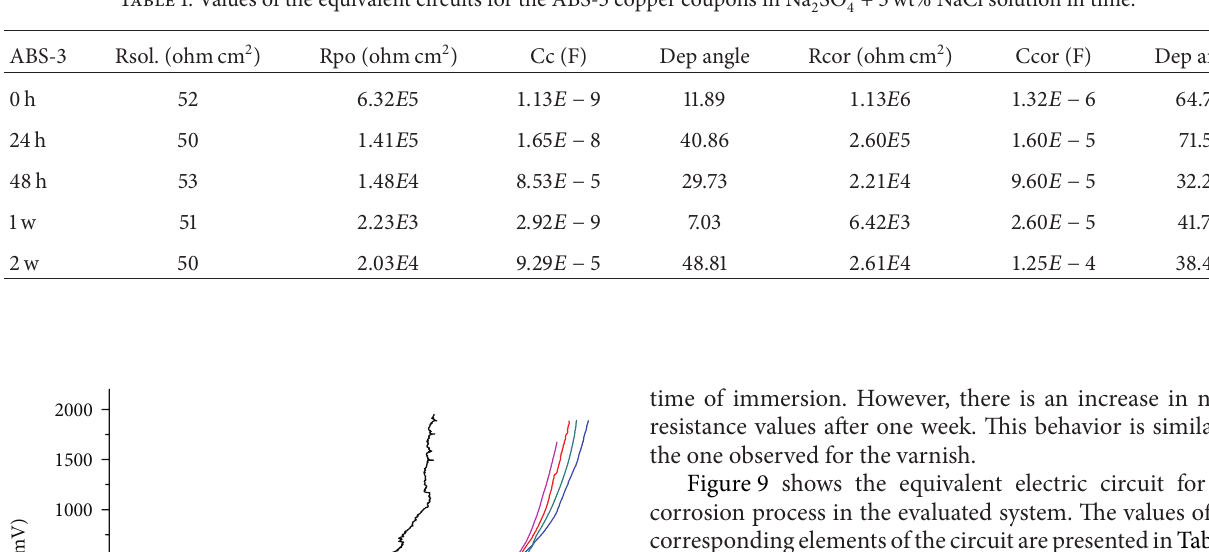
Table 1: Values of the equivalent circuits for the ABS-3 copper coupons in Na